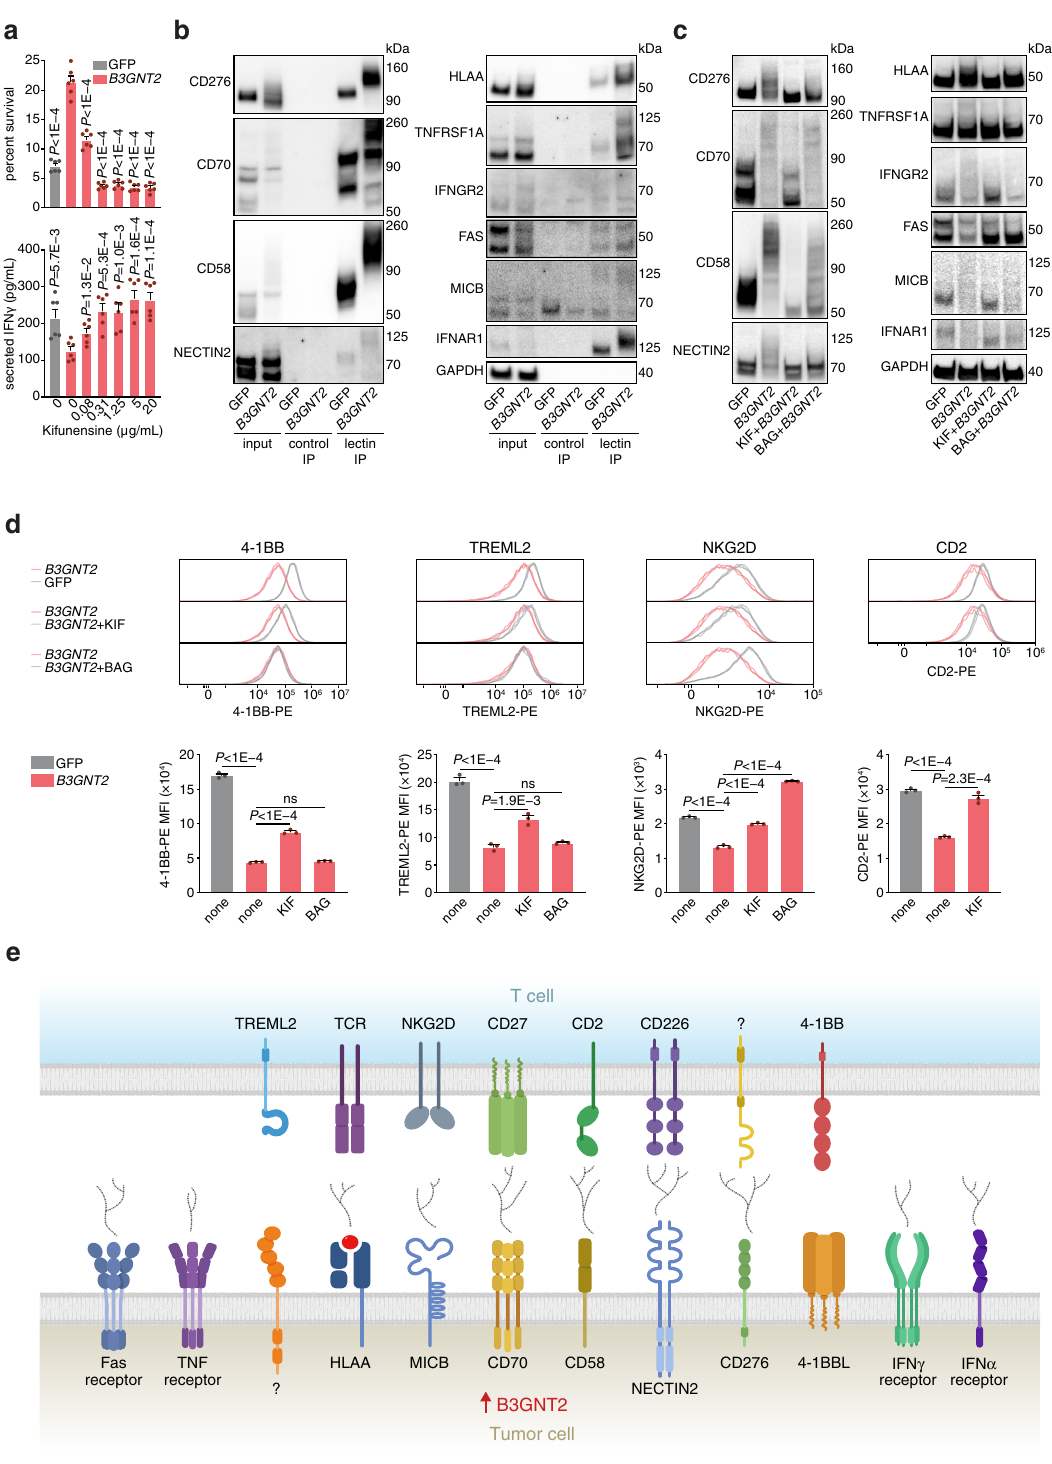
4-1BB binds to other unknown ligands that are targeted by B3GNT2. For TREML2, though some studies have suggested that TREML2 interacts with the B3GNT2 target protein CD276 52 , CRISPR knockdown of CD276 did not affect binding to TREML2 (Supplementary Fig. 9f – h). Our fi nding aligns with a previous study showing that the interaction between TREML2 and CD276 does not occur in humans 53 . Taken together, we have shown that B3GNT2 overexpression confers resistance against T cell cyto- toxicity by adding poly-LacNAc on numerous proteins to NATURE COMMUNICATIONS| (2022) 13:1606